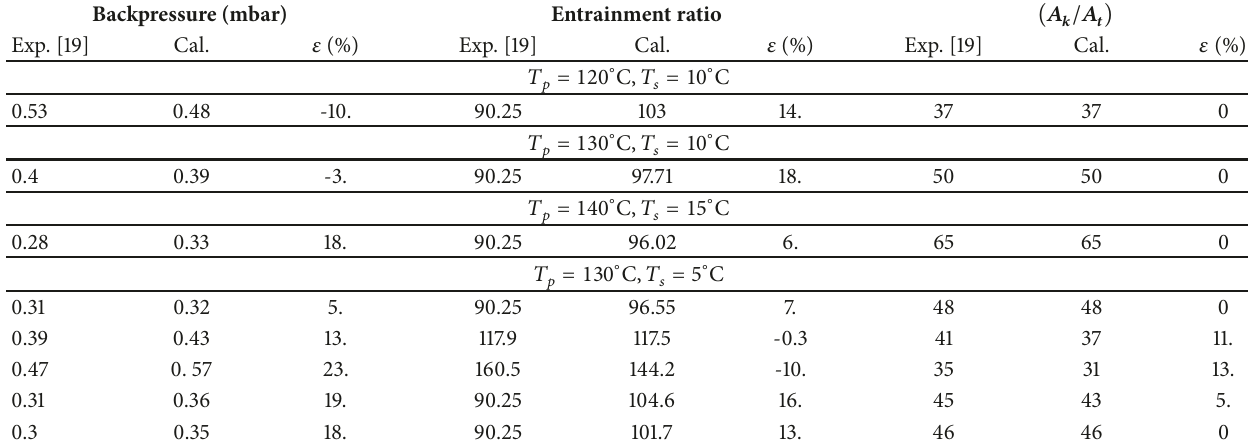
Table 5: Ejector model validation ( 𝑇 𝑝 , primary flow temperature; 𝑇 𝑠 , entrained flow temperature; (𝐴 𝑘 /𝐴 𝑡 ) , ejector area ratio, i.e., ratio of constant area section, 𝐴 𝑘 , and nozzle throat area, 𝐴 𝑡 ). B ackpressure (mbar)